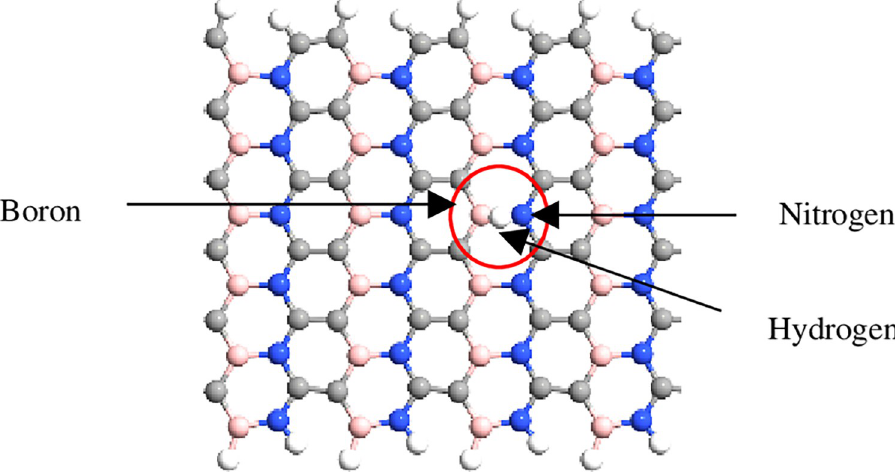
Fig 4. Optimized structures of 12-BC 2 NNR with different positions of H 2 gas molecules at both boron and nitrogen atoms.